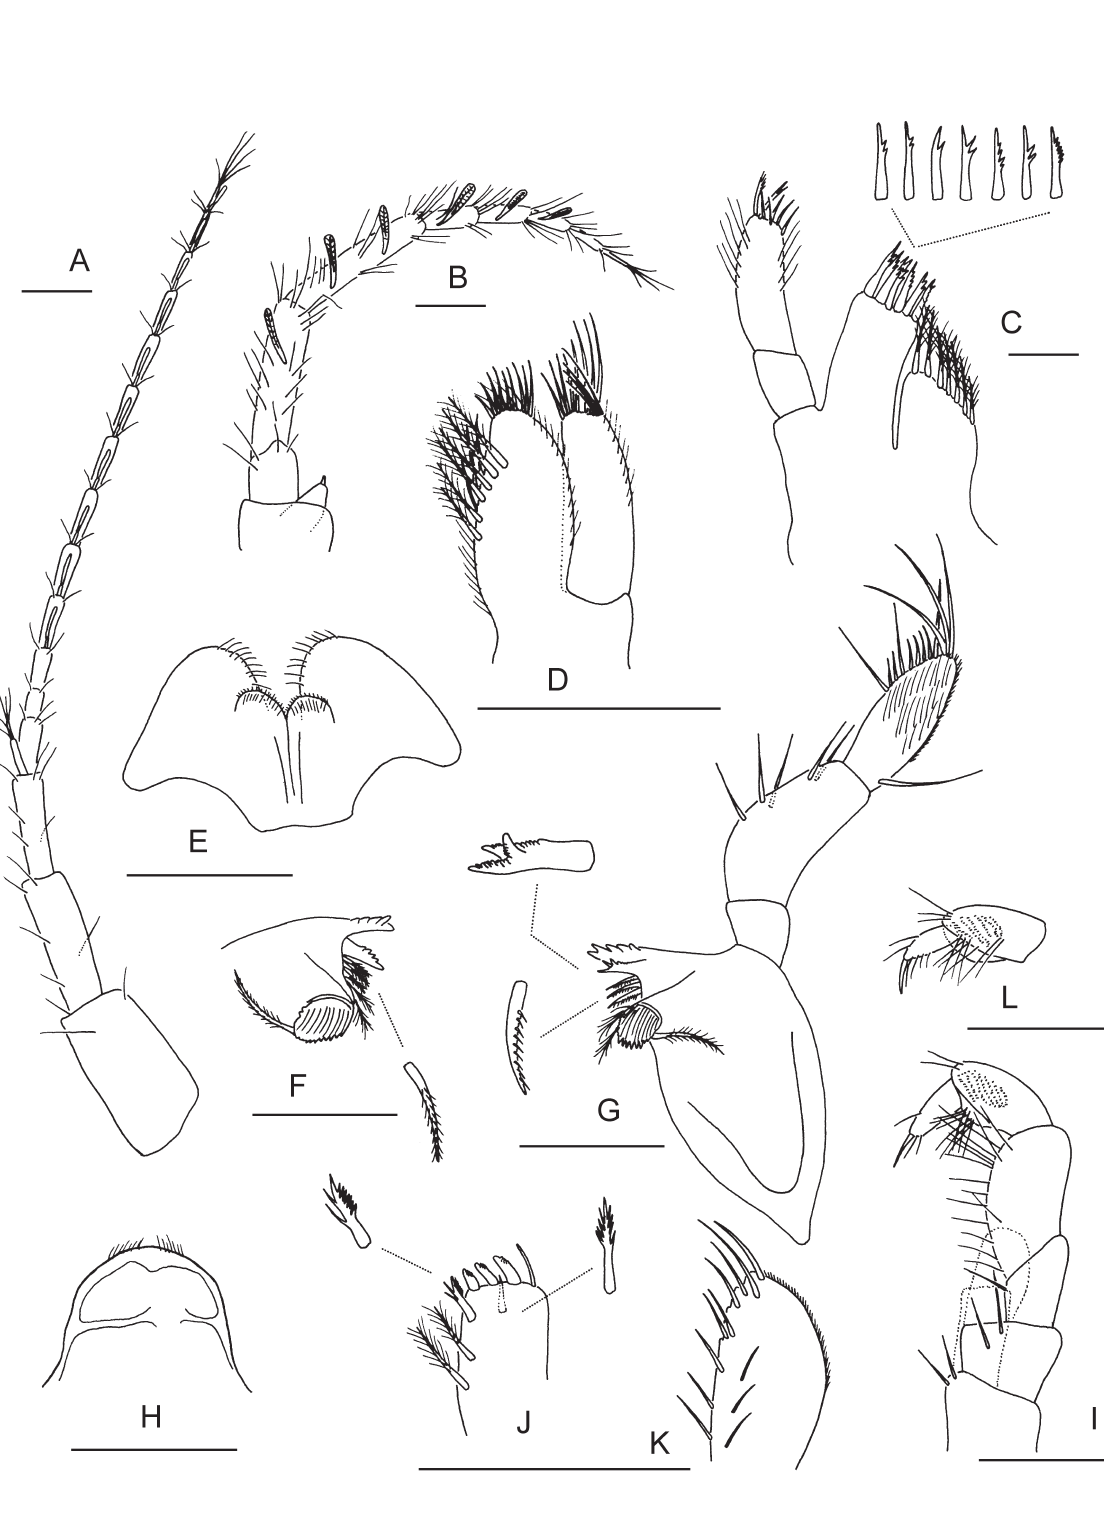
Fig. 4A-L. Synurella ambulans (F. Müller, 1846), ♂, 4.5 mm, FENU X34906/Cr-1406, MO. A . Antenna 1. B . Antenna 2. C . Maxilla 1. D . Maxilla 2. E . Lower lip. F . Left mandible. G . Right mandible. H . Upper lip. I . Maxilliped. J . Maxilliped, inner plate. K . Maxilliped, outer plate. L . Distal part of maxilliped palp, female, 6.0 mm, FENU X34906/Cr-1406, PP. Scale bars 0.2